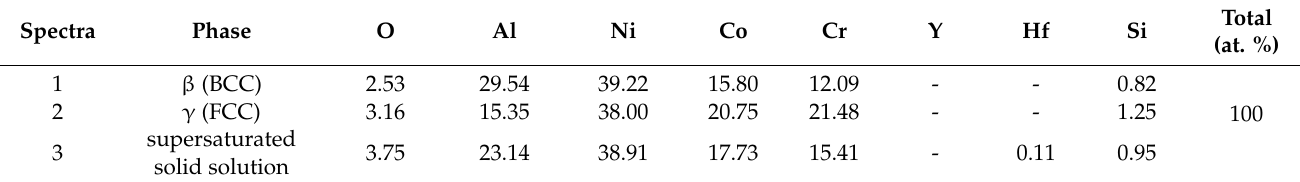
Table 2. Results of EDS analysis of the VPS bond coat shown in Figure